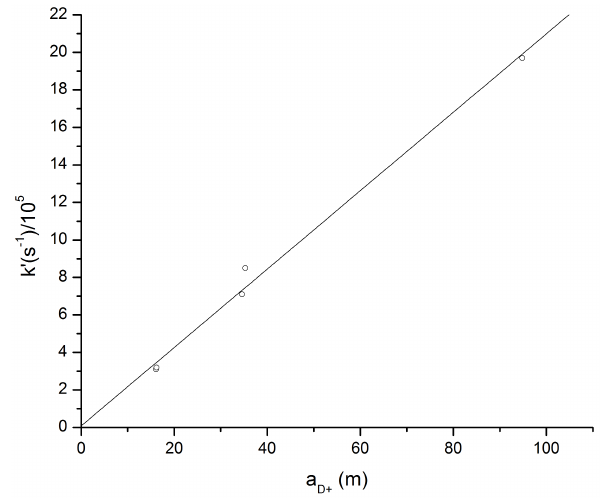
Fig. 8. k 0 for diester formation in DClO 4 as a function of AIOMFAC-calculated proton activity (data from Table 7).